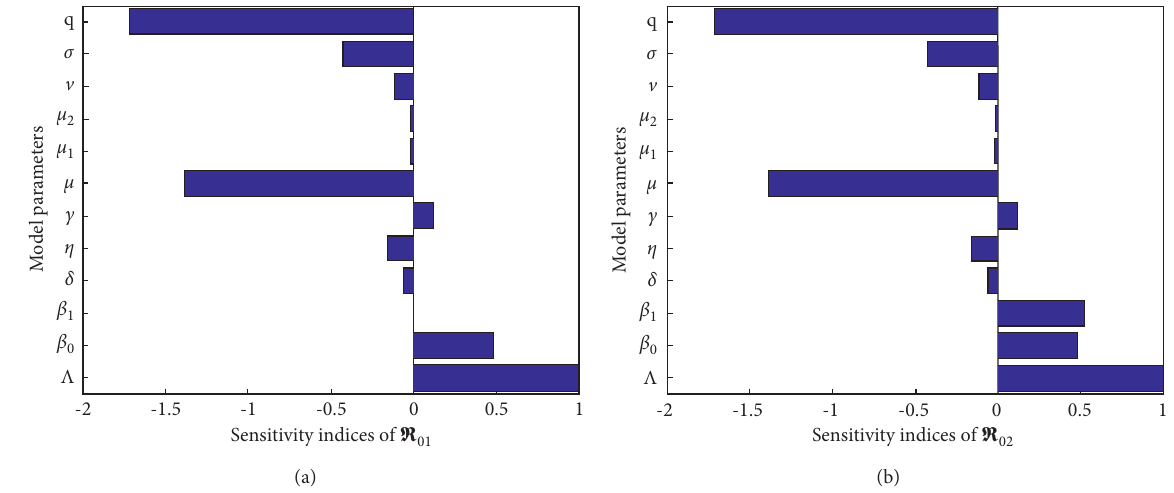
Figure 3: Sensitivity index of the model parameters in (a) R